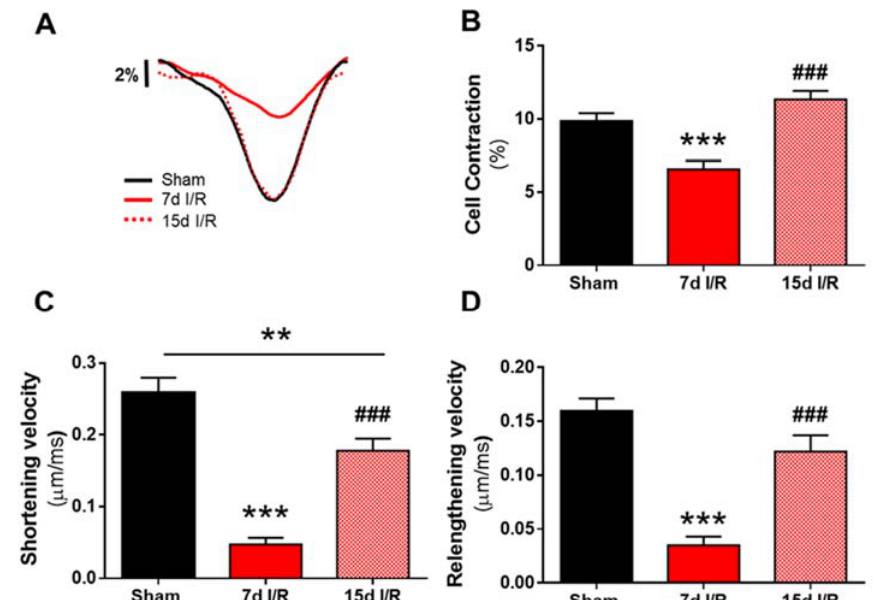
Figure 1. Contractility of electrically-stimulated cardiomyocytes after renal ischemia and reperfusion. ( A ) Cell contraction profiles of cardiomyocytes from sham-treated mice (black line) and from mice subjected to ischemia and reperfusion (I/R) for 7 (red line) and 15 (red discontinuous line) days. ( B–D ) Cell contraction ( B ), shortening ( C ) and re-lengthening ( D ) velocities. Cardiomyocytes were electrically stimulated at 2 Hz. Data are expressed as mean ± SEM. ** p < 0.01, *** p < 0.001 versus sham, ### p < 0.001 versus 7 d I/R; sham ( n = 73 cells, N = 10 mice), 7 d I/R ( n = 39 cells, N = 10 mice) and 15 d I/R ( n = 90 cells, N = 6 mice).